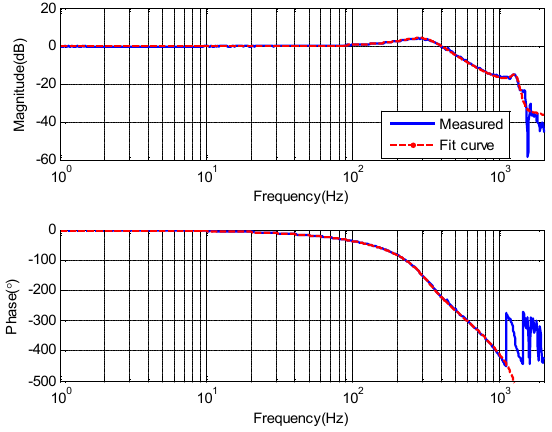
Figure 3. The close loop characteristic of the FSM inner position loop. Figure 3 . The close loop characteristic of the FSM inner position loop.